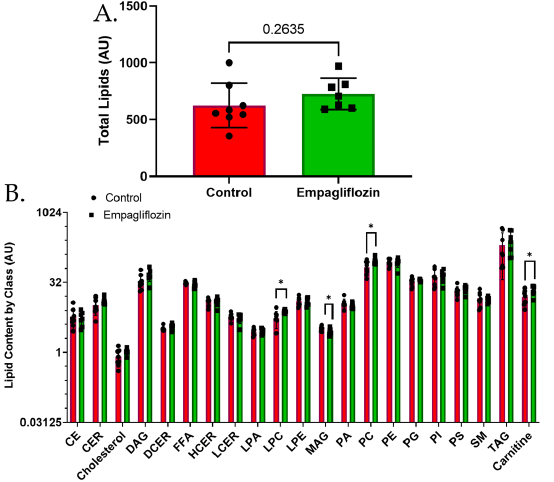
Figure 6. Overall abundance of lipids of various classes in kidney with EMPA. ( A ) Total lipid quantity was not significantly different. ( B ) Separation of lipid species into classes revealed increased levels of lysophosphocholines (LPC), phosphocholines (PC), and carnitines, while monoacylglycerols (MAG) were reduced; * indicates significantly different by unpaired t -test.